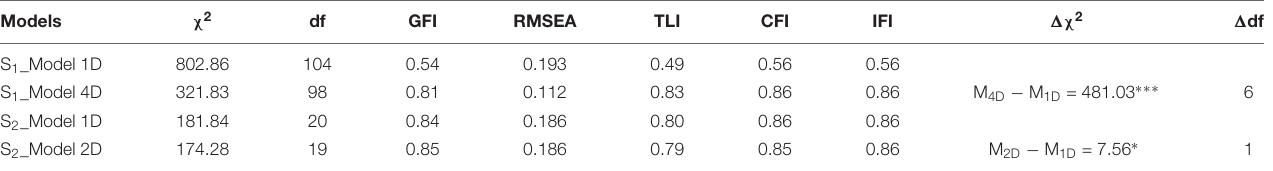
TABLE 4 | Confirmatory factorial analysis for employees ( n = 181) and unemployed ( n = 237) samples.